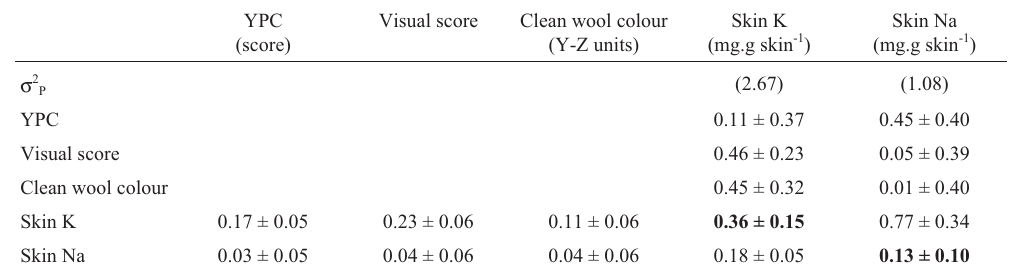
Table4 -Estimatesforgenetic(abovediagonal)andphenotypic(belowdiagonal)correlations( ± standarderror)betweenYPCandcleanwoolcolourand whole skin minerals analysed in Corriedale flock. Hereability estimates are shown in